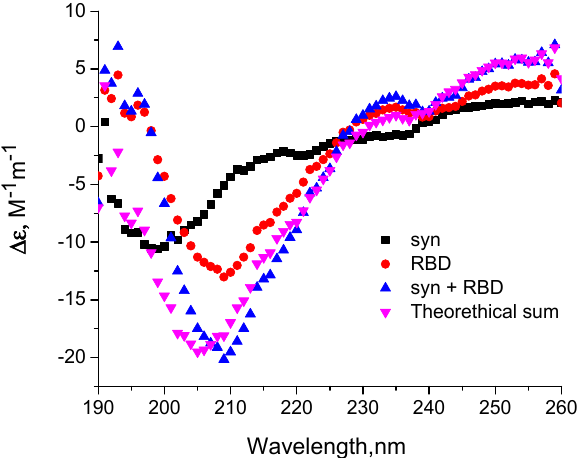
Figure 5. Influence of alpha-synuclein on circular dichroism spectra of SARS-CoV-2 RBD. CD spectra of 20 μ M alpha-synuclein (squares) and 20 μ M SARS-CoV-2 RBD (circles), equimolar mixture of Syn and RBD (blue triangles pointed up), and theoretical sum (violet triangles pointed down) are shown. CD spectra of the investigated samples were recorded after buffer exchange to 10 mM po- tassium phosphate buffer, pH 7.4. Each spectrum is an average of five records.